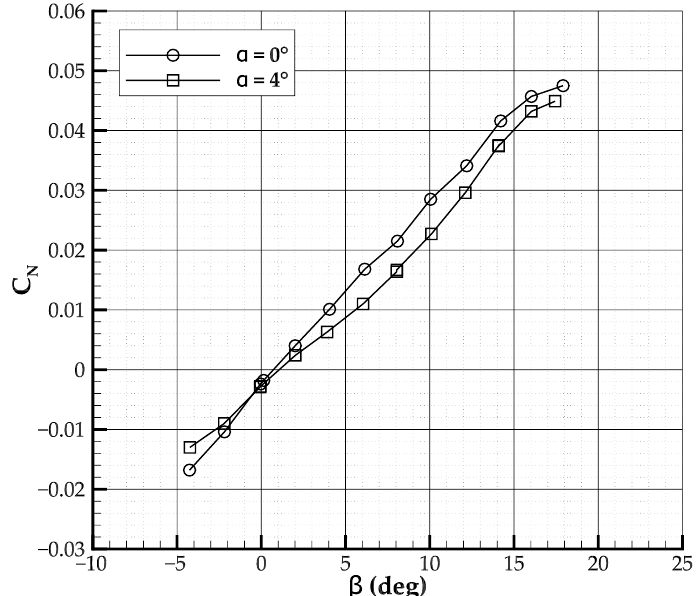
Figure 16. Effect of the angle of attack on the yawing moment coefficient for the WBHV configuration. Reference point at x CG = 0, V = 35m/s, Re =